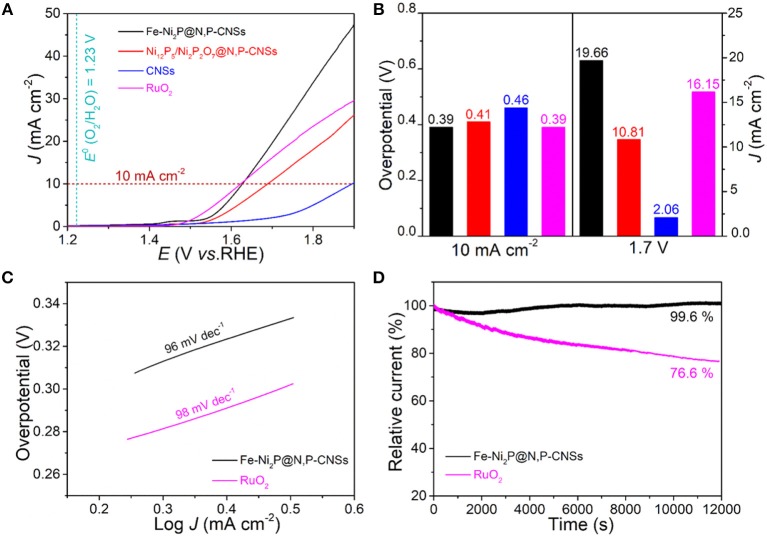
Comparison of the electrochemical OER performance of Fe-Ni2P@N,P-CNSs, Ni12P5/Ni2P2O7@N,P-CNSs, CNSs and commercial RuO2 catalysts: (A) OER polarization curves, (B) overpotentials at 10 mA cm−2 and current densities achieved at 1.7 V, (C) corresponding Tafel plots, and (D) chronopotentiometry curves of the Fe-Ni2P@N,P-CNSs and RuO2 catalyst at 1.6 V in O2-saturated 0.1 M KOH.